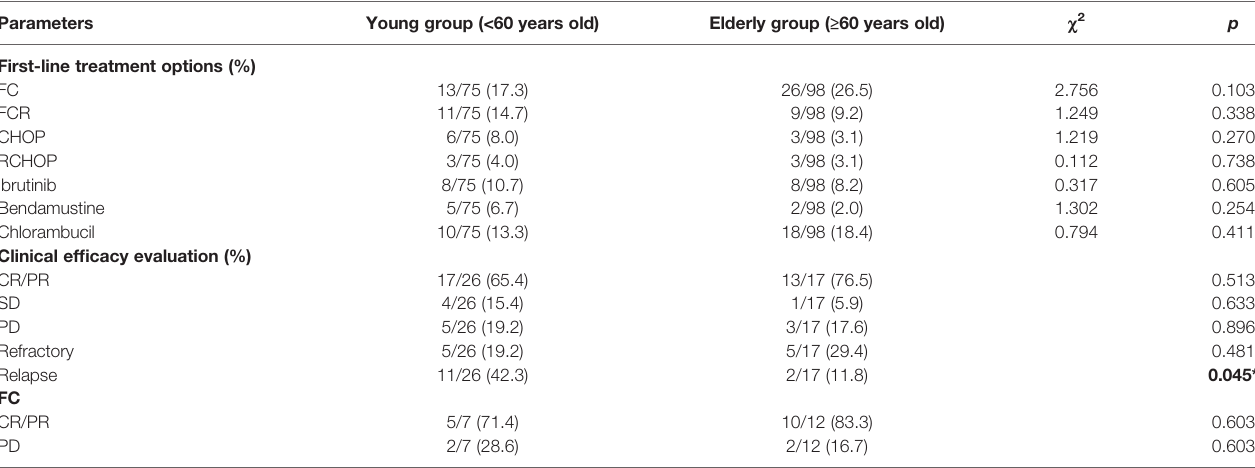
TABLE 2 | First-line treatment options and clinical ef fi cacy evaluation in young and elderly CLL patients. Parameters